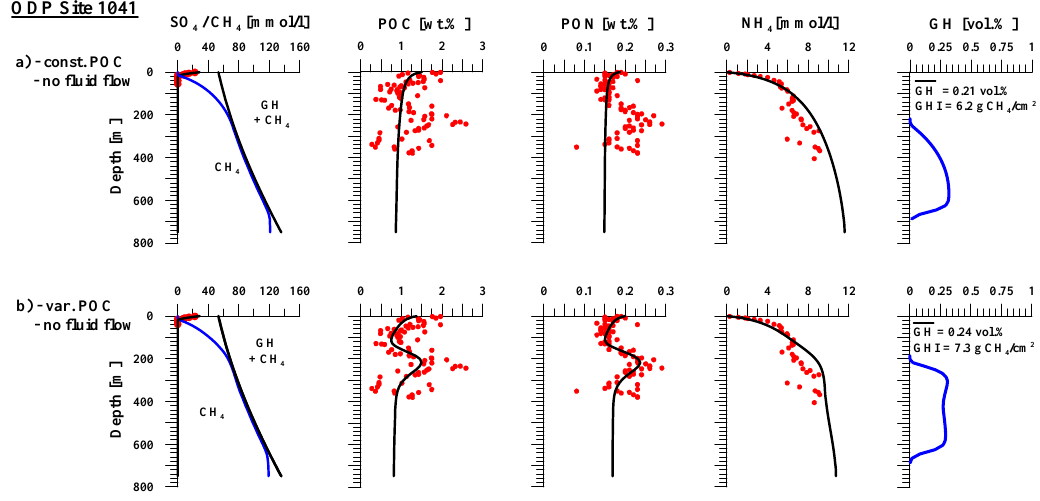
Fig. 2. Model results for ODP Site 1041 off Costa Rica for two different model runs: a) constant POC input, and b) varying POC input over time. Average GH concentrations (GH) are provided in vol.% of pore space, and as depth-integrated mass per area seafloor (GHI in g of CH 4 /cm 2 ).